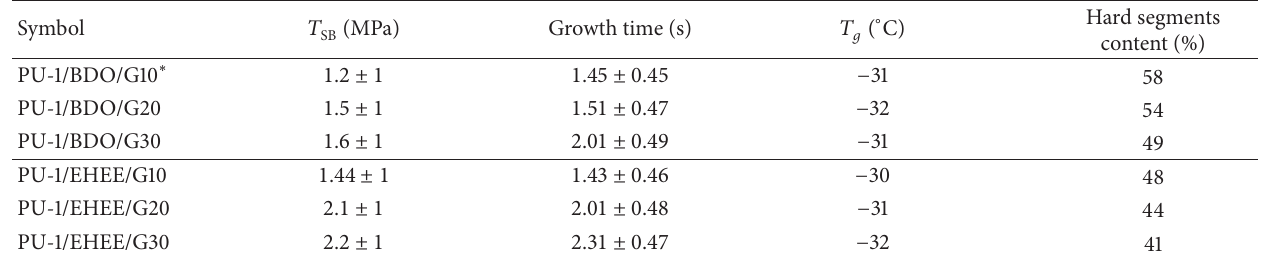
Table 3: Characteristics of gelatin-modified PU